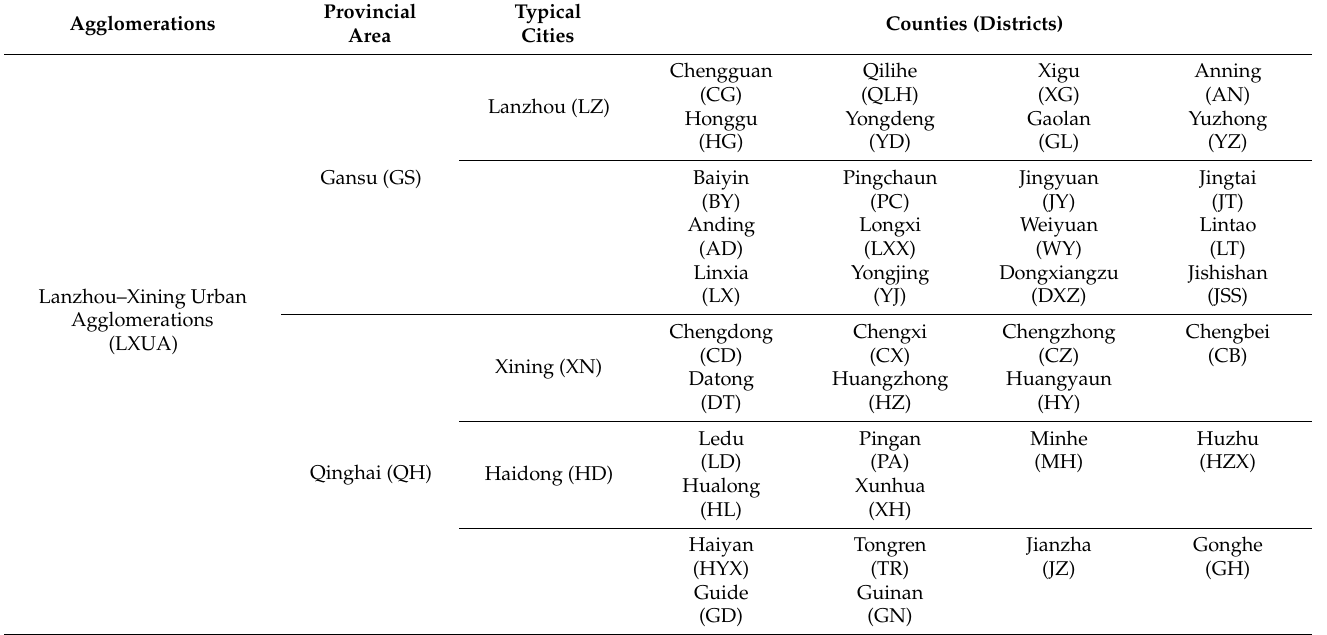
Table 1. The administrative divisions of the research